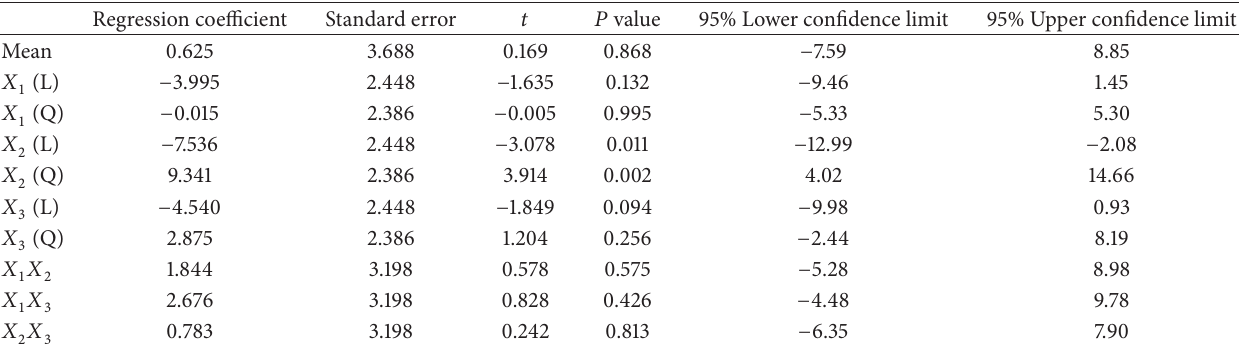
Table 2: Results of linear (L) and quadratic (Q) regression analyses applied to residual doxycycline concentration data collected at the end of the Fenton process under different operating conditions.